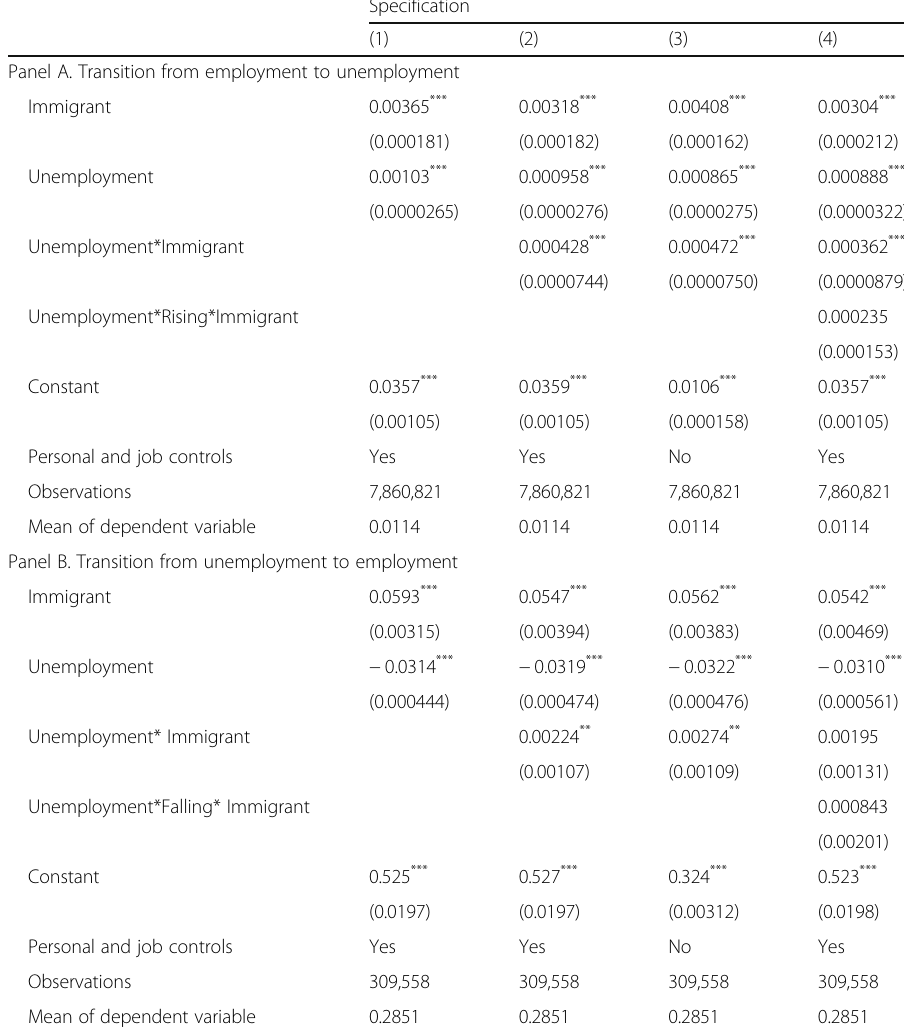
Table 14 Two-way transitions between employment and unemployment: matched CPS data, 1996 –